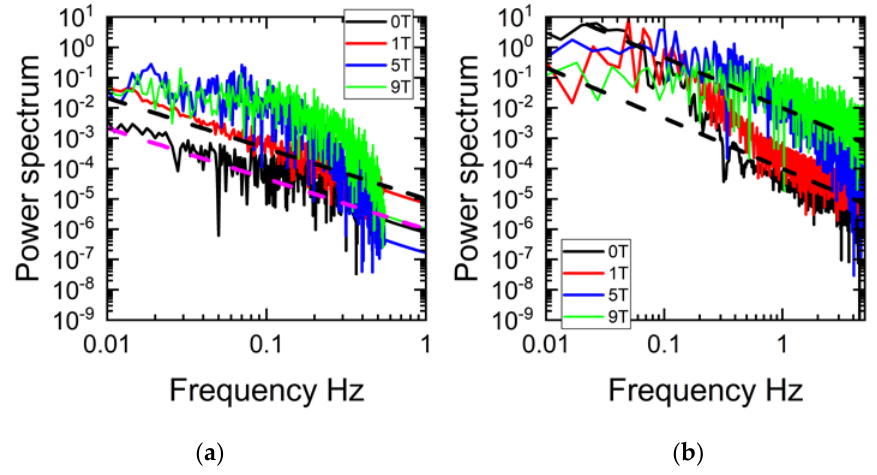
Figure 9. Power spectrum of the temperature for the case with Δ T = 11 °C ( a ) experimental and ( b ) numerical.